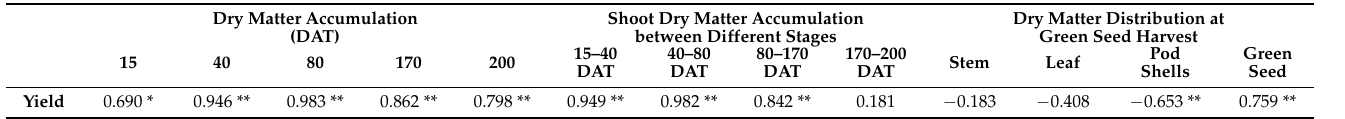
Table 5. The correlation between the indices of dry matter accumulation in shoot and green seed yield.